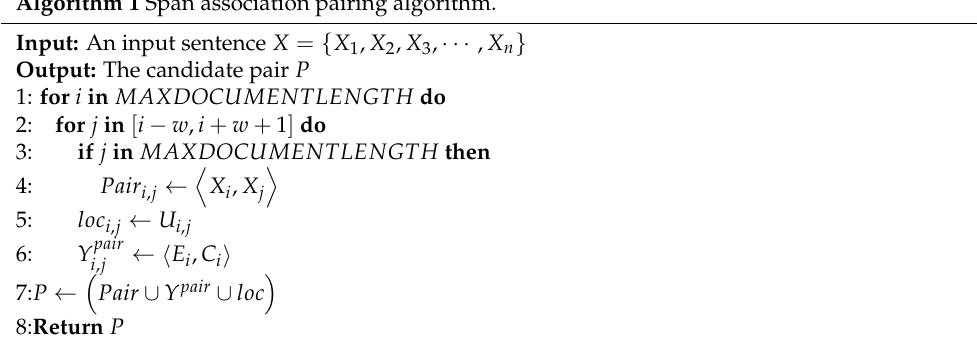
Algorithm 1 Span association pairing